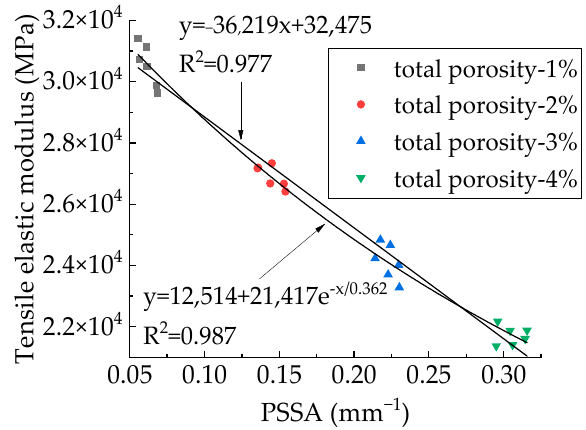
Figure 18. Relationship between PSSA and elastic modulus.